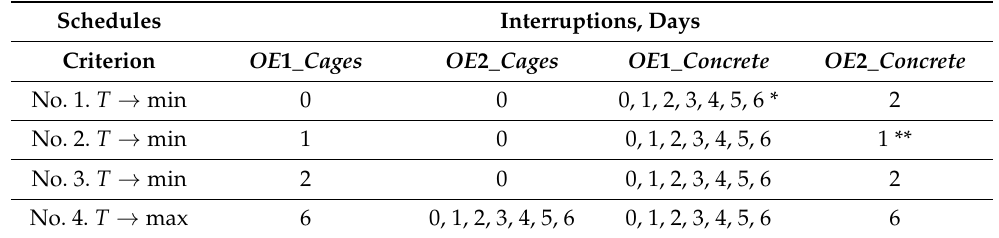
Figure 7. Distribution of resources in time: schedule of machine operations ( a ), schedule of work performance by the core construction workers ( b ).